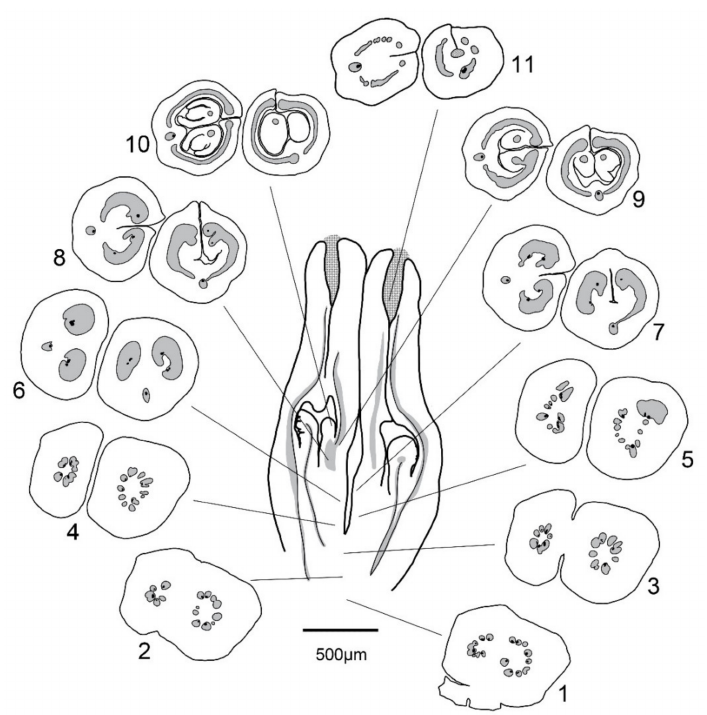
Figure A2. Carpel architecture of Anaxagorea luzonensis in flower stage – longitudinal section with related ascending transverse sections.